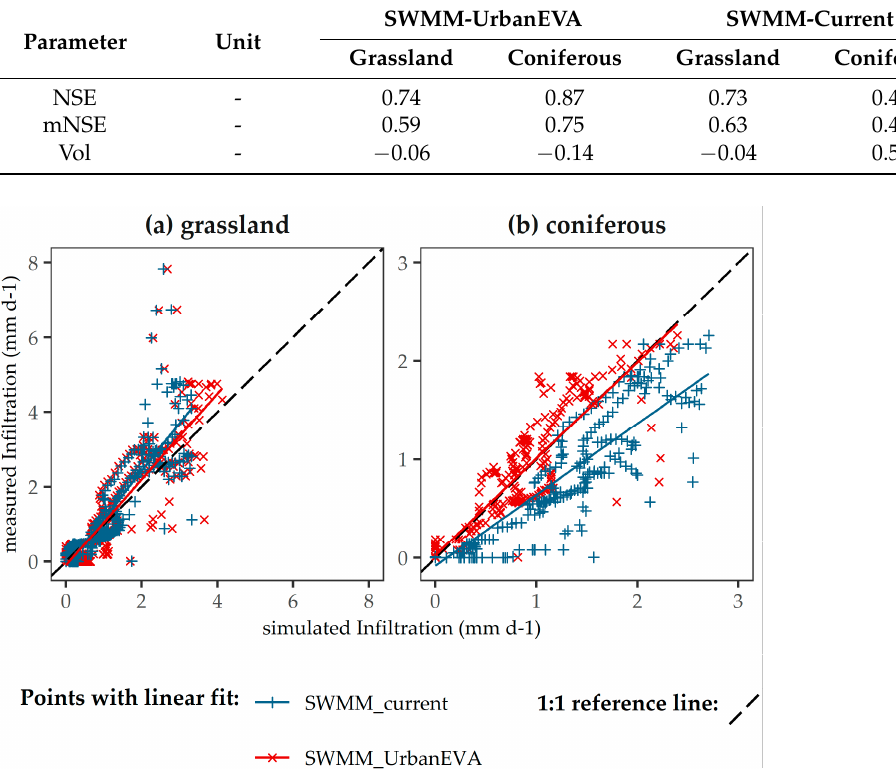
Figure 8. Parity plots of daily infiltration in 1992 modeled by SWMM-UrbanEVA and SWMM-current for ( a ) grassland and ( b ) coniferous at full scale lysimeter St. Arnold.